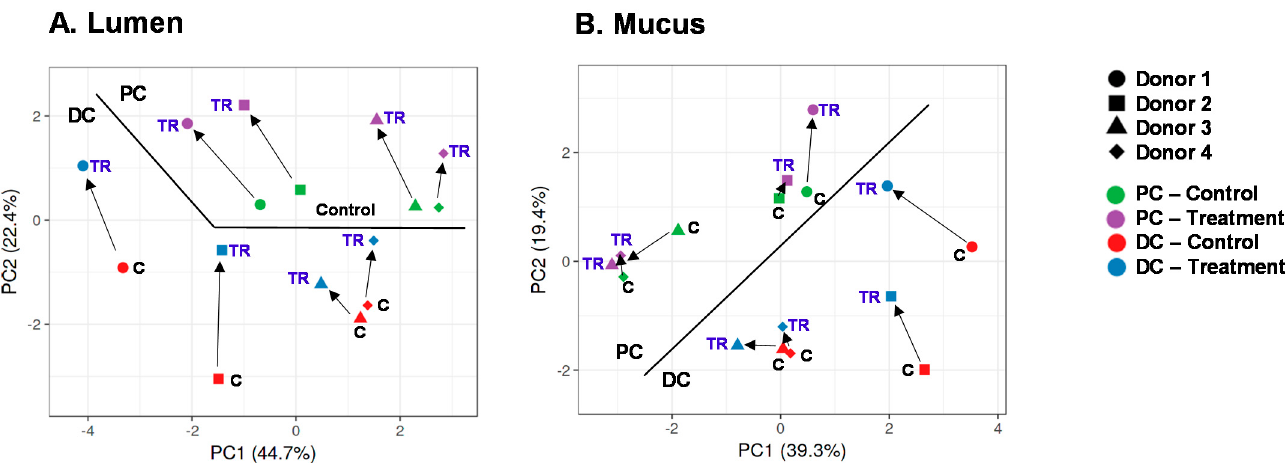
Figure 6. Principal component analysis (PCA) based on luminal ( A ) or mucosal ( B ) microbial composition in the proximal and distal colon of the quad-M-SHIME at the end of the control (C: Day 14) and treatment period (TR: Day 35). The PCA is based on data of the 10 most abundant families as detected via 16S-targeted Illumina sequencing across all samples. Arrows indicate the chronological evolution of samples along the experiment. cRG-I = carrot-derived Rhamnogalacturonan I, DC = distal colon, PC = proximal colon.